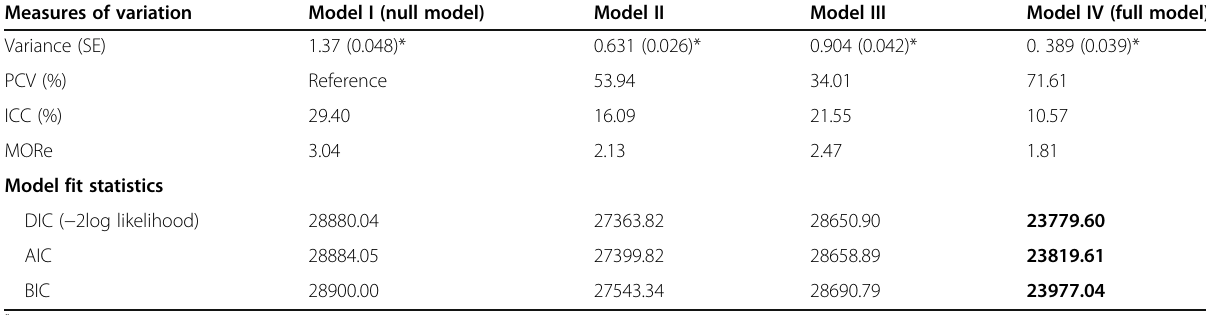
Table 4 Measures of variation and model fit statistics on childhood immunization in sub-Saharan Africa Measures of